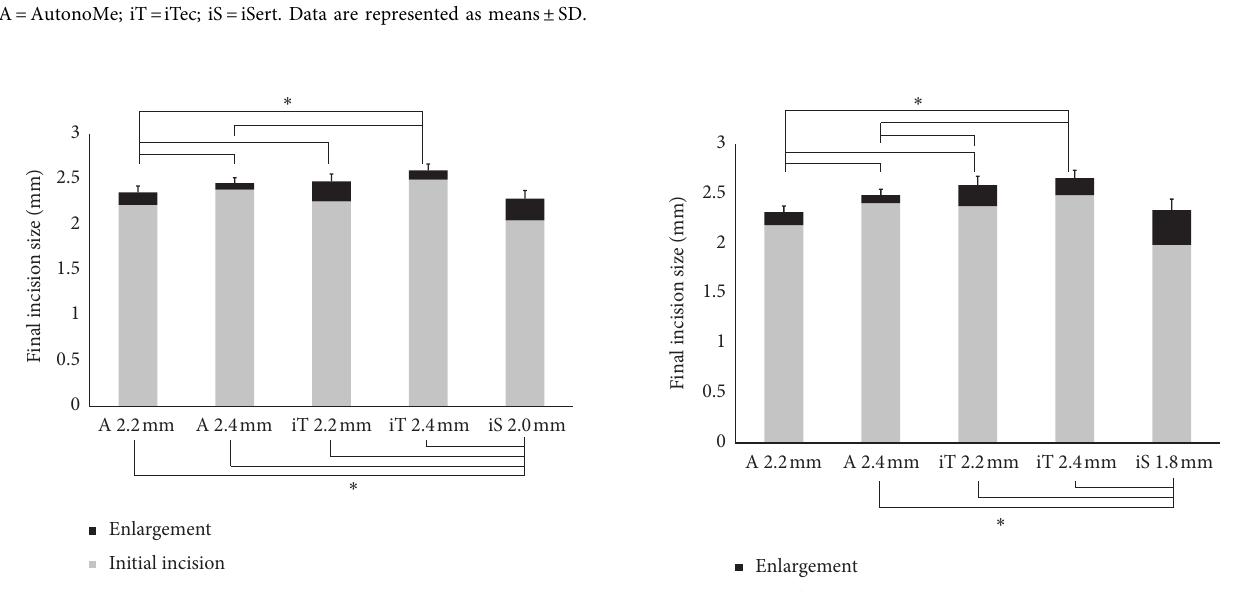
Figure 3: Mean final incision size (initial incision size+ enlarge- ment) with corneal incisions ( ± SD) ( ∗ P < 0 . 05, one-way analysis of variance) (A � AutonoMe; iT � iTec; iS � iSert).